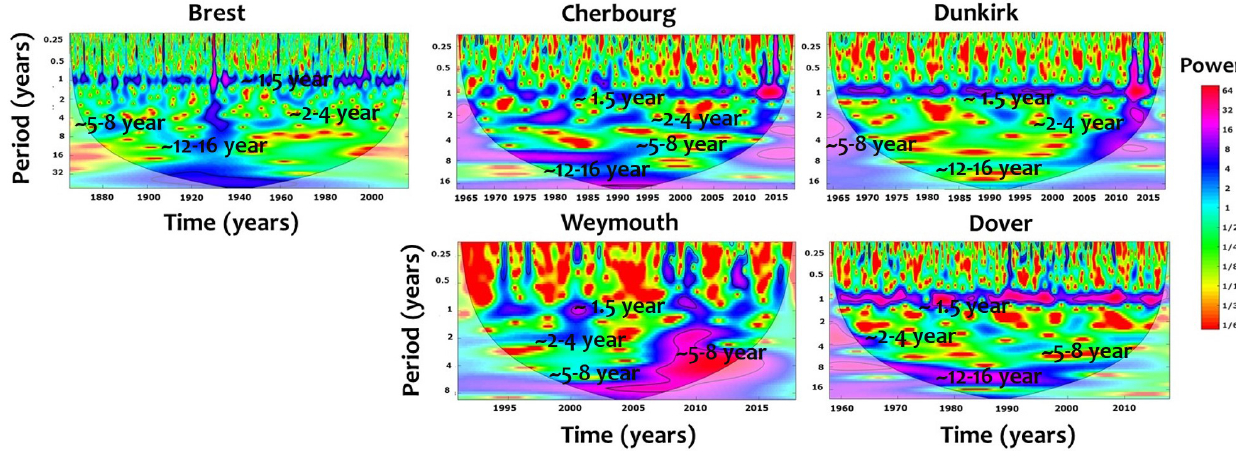
Figure 2. CWT of monthly maxima of surges in Brest, Cherbourg, Dunkirk, Dover and Weymouth.